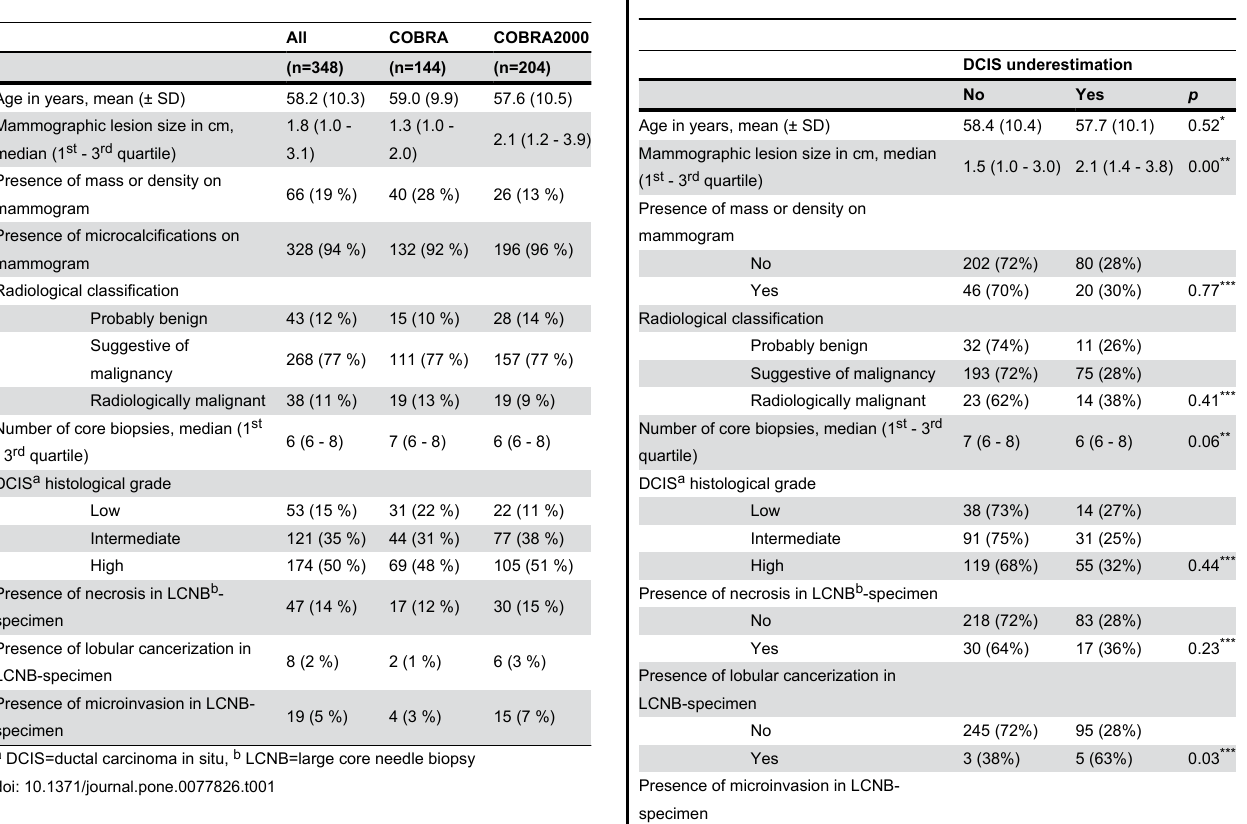
Table 1. Patient characteristics. Table 2. Association between DCIS a underestimation and preoperative